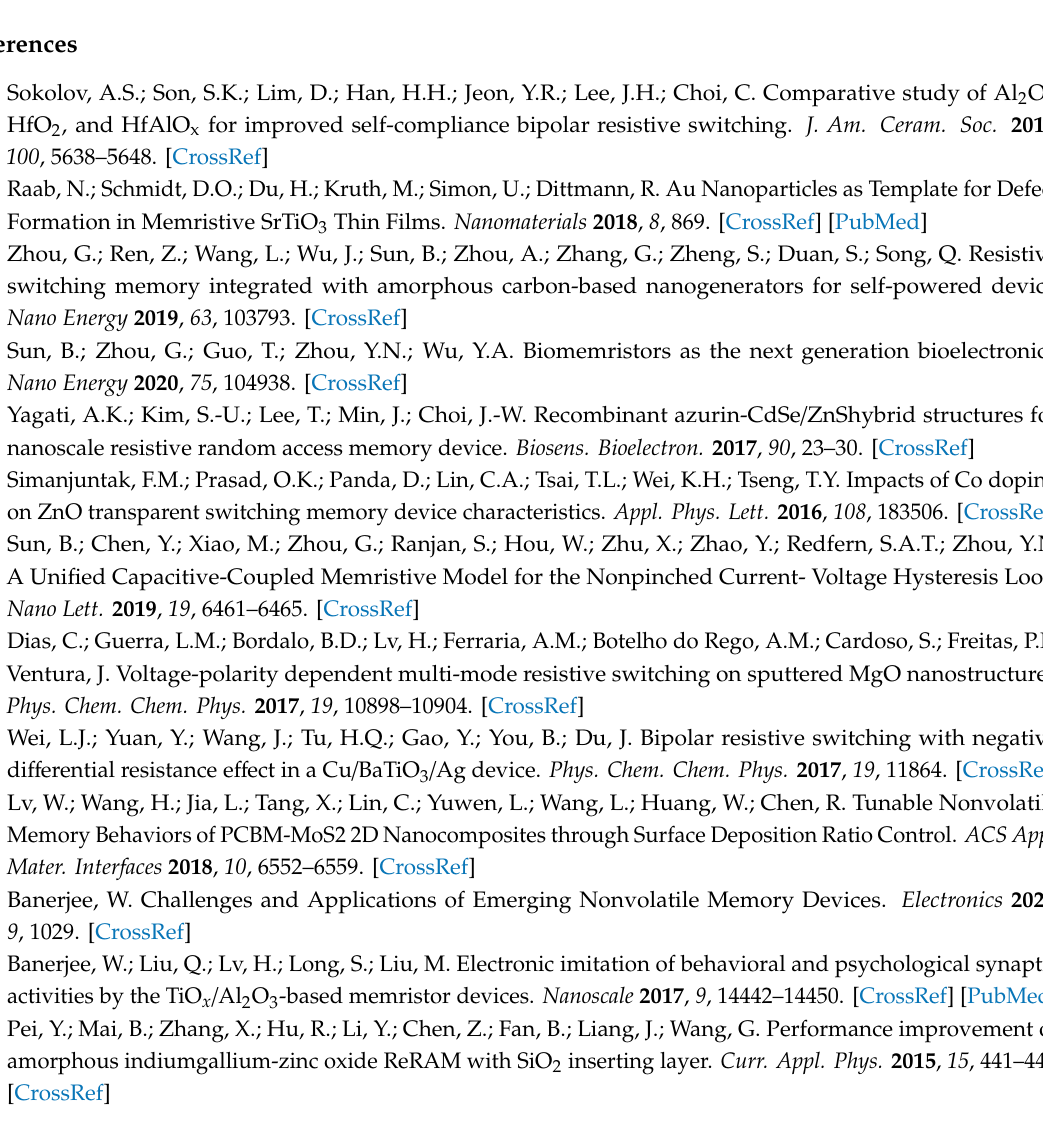
Figure S1: The subsequent 10 consecutive voltage sweeps for CoAl-LDHs memristor, Figure S2: Sample-to-sample I-V characteristic for 30 CoAl-LDHs memristors, Figure S3: Representative I-V plots of the remaining 19 devices which show a single resistive state. (a) I-V characteristic of the first device. (b) I-V characteristic of the seventh device. (c) I-V characteristic of the sixteenth device, Figure S4: Data retention characteristics of the tenth Co-Al LDHs memristor, Figure S5: Endurance characteristics of the tenth Co-Al LDHs memristor, Figure S6: The subsequent 10 consecutive voltage sweeps for CoAl-LDHs after hexazinone adsorption memristor, Figure S7: Sample-to-sample I-V characteristic for 39 CoAl-LDHs after hexazinone adsorption memristors, Figure S8: Data retention characteristics of the tenth CoAl-LDHs after hexazinone adsorption memristors, Figure S9: Endurance characteristics of the tenth CoAl-LDHs after hexazinone adsorption